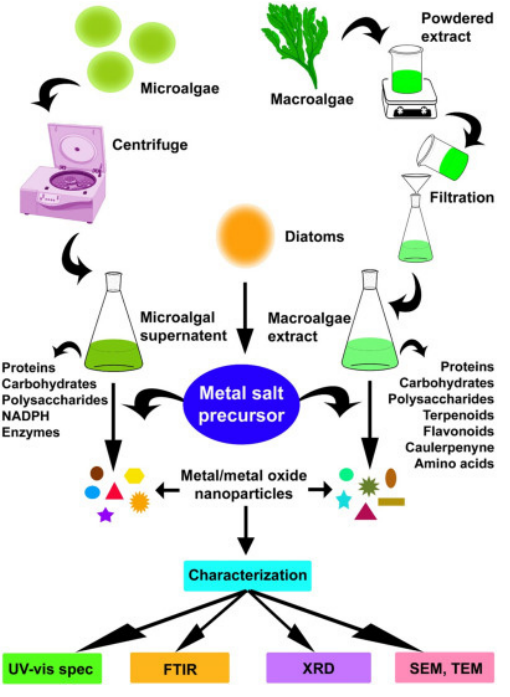
Figure 4. Synthesis route and characterization of algae-based metal and metal oxide NPs. Reprinted from [62] with permission from Elsevier.